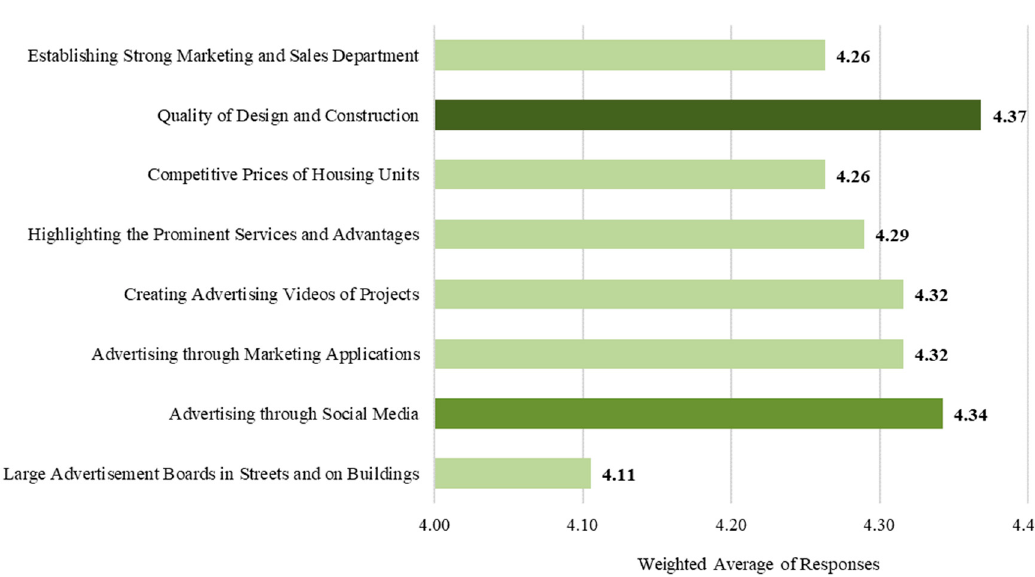
Figure 13. Consensus-Based Marketing Measures as Proposed by Experts.